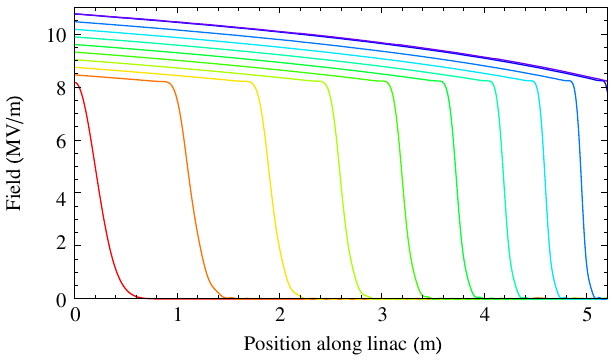
FIG. 2. Electric field along the length of the linac given in the table traced out at 100-ns intervals starting at t ¼ 0 (red). The rf drive is as shown in Fig. 4 tuned for 100-mA beam current. The leftmost (red) trace is the initial field profile at t ¼ 0 , and the ð z Þ uppermost (blue) trace is the static field (cid:2) E z